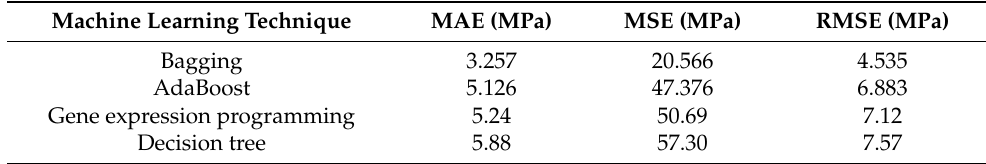
Table 2. Statistical checks of the models.